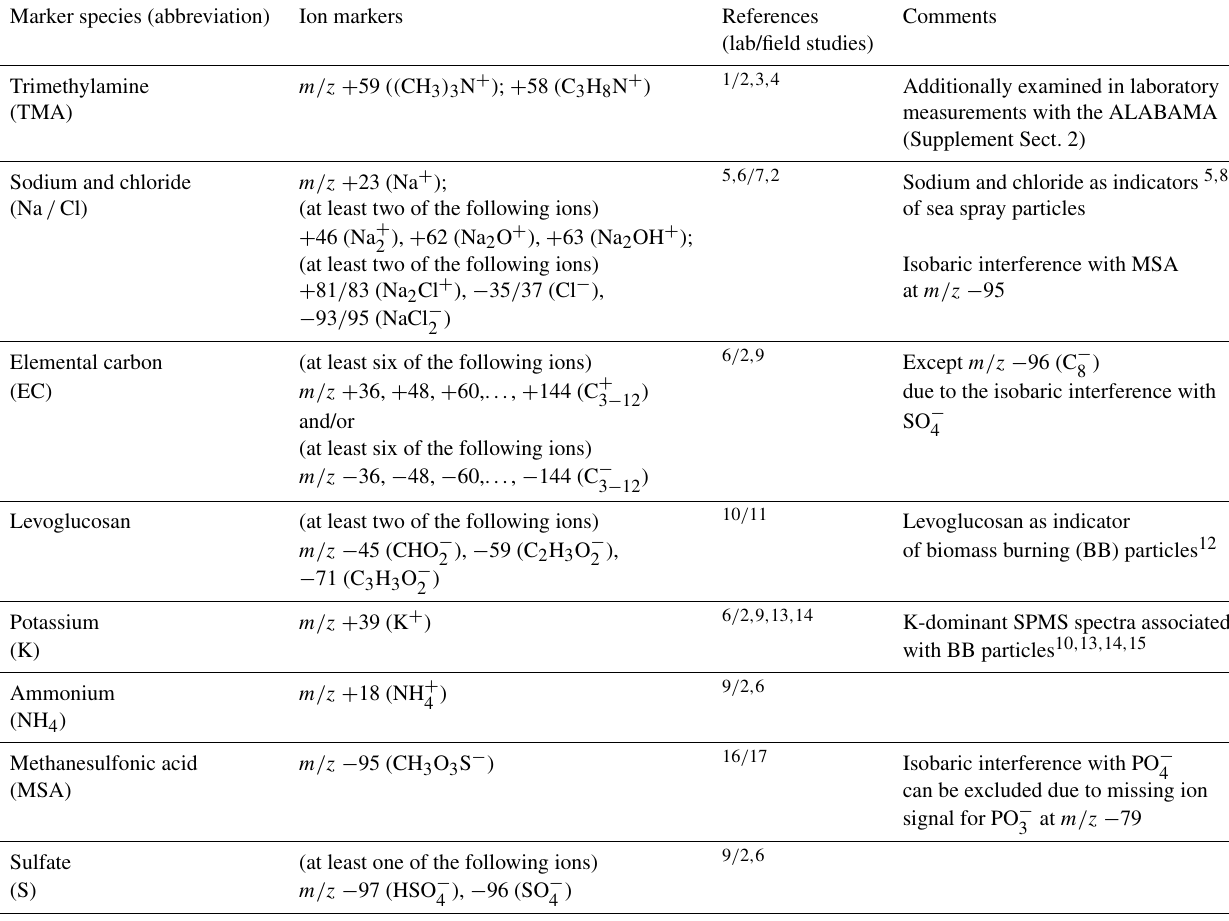
Table 1. Marker species (with abbreviations) and associated ion markers used in this study. Further given are references (SPMS lab and field studies) used for the assignment of ion markers as well as additional comments on marker species and